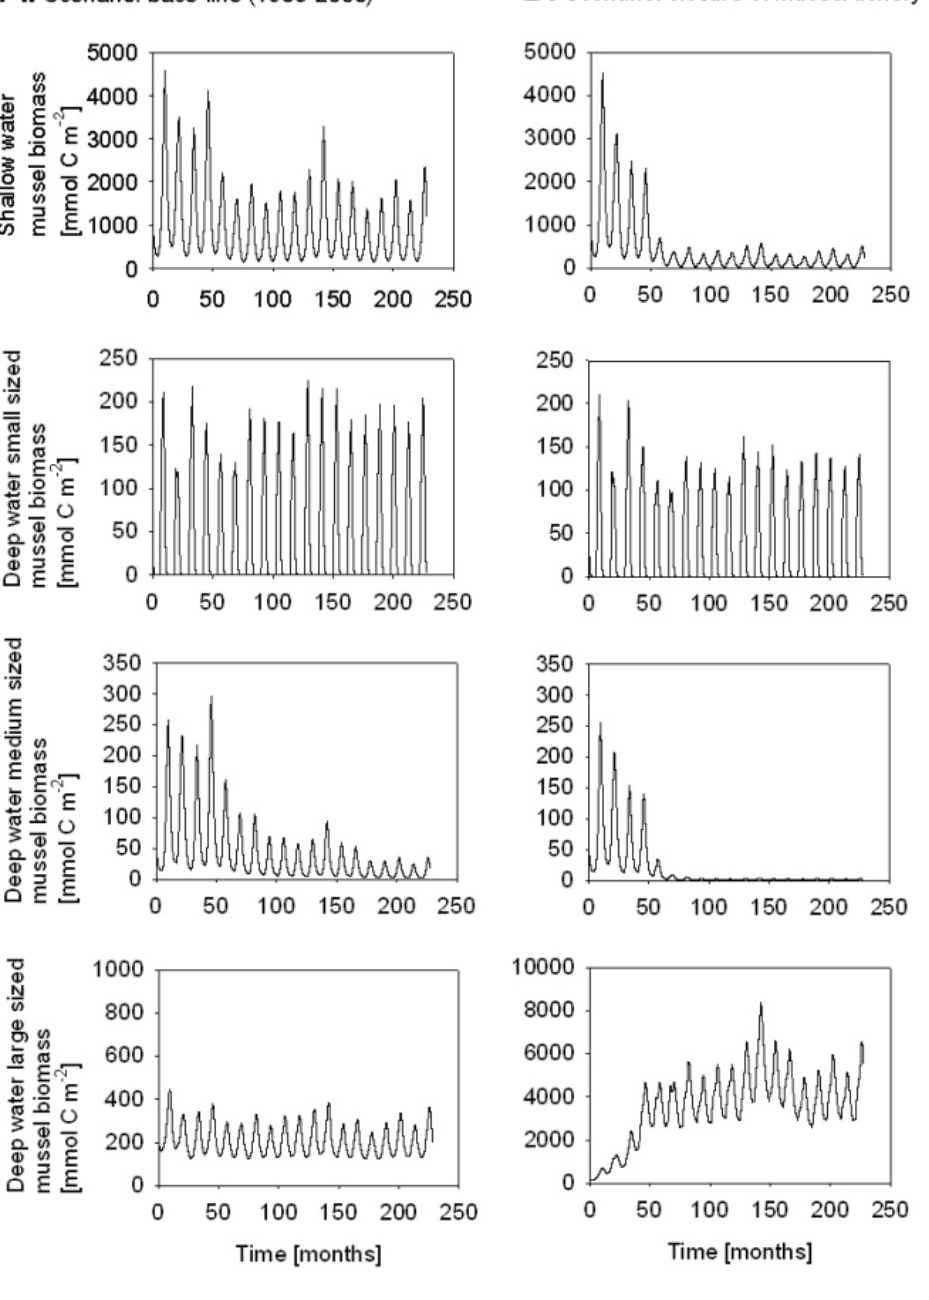
Fig. 6. Results of model simulation for Scenario 2. Impact of mussel fishery activity as recorded from 1985-2003 (A), and total closure of mussel fishery (B), on (from top to bottom) shallow-water (< 2 m) mussel biomass, and biomasses of deep- water (> 2 m) small, medium, and large-sized